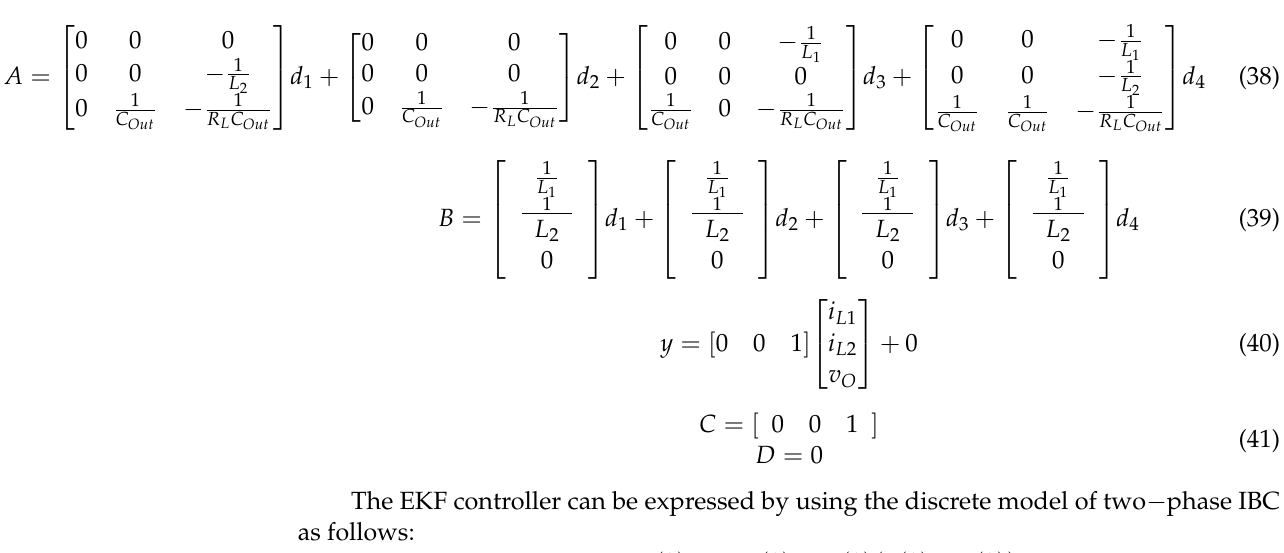
Table 1. PV Module and Circuit Parameters.